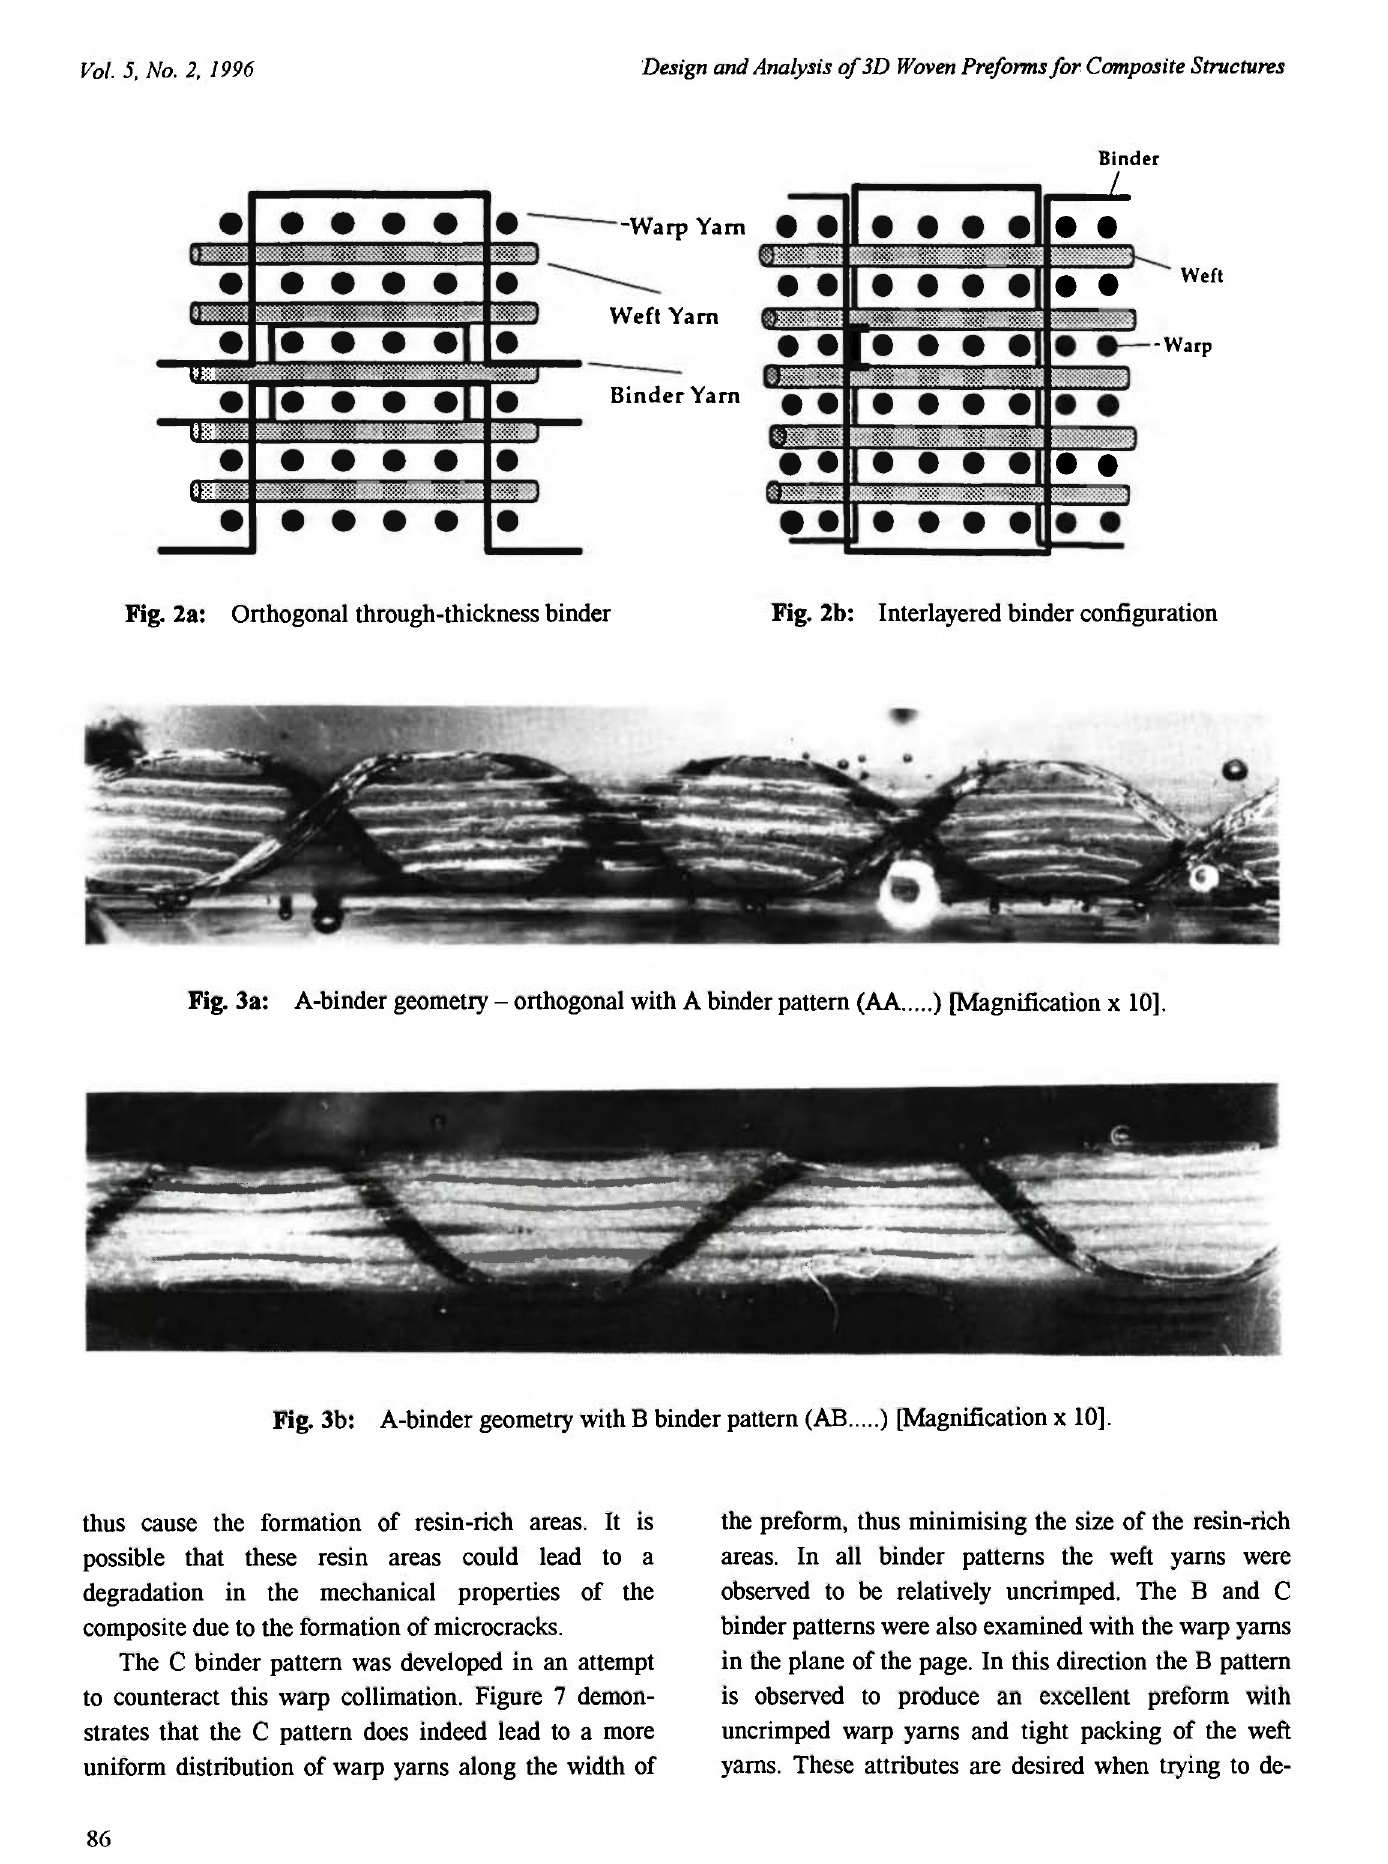
Fig. 3b: Α-binder geometry with Β binder pattern